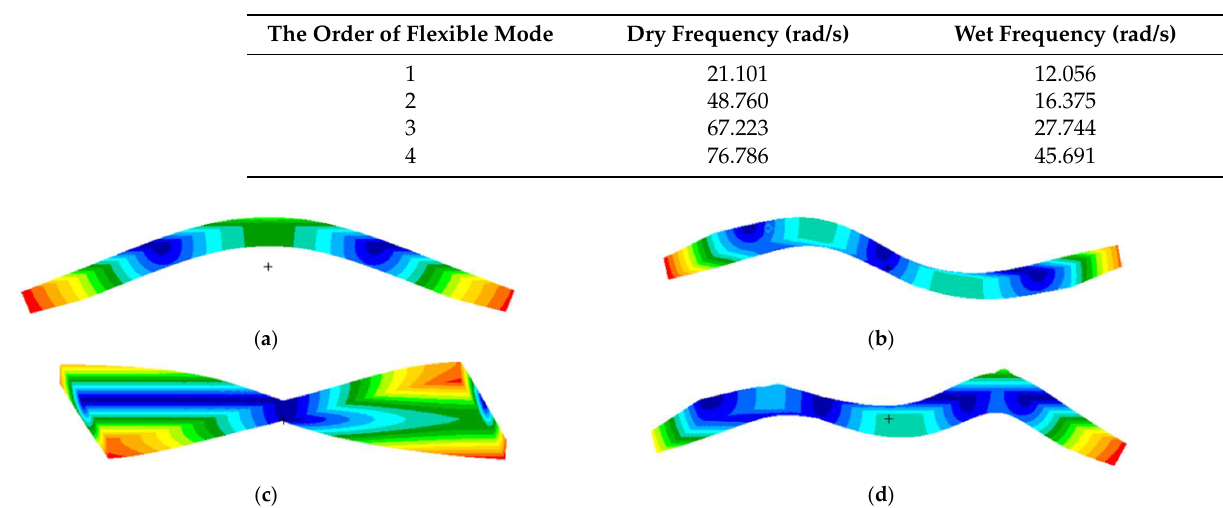
Figure 4. Numerical simulation model. ( a ) Structural model. ( b ) Hydrodynamic model.